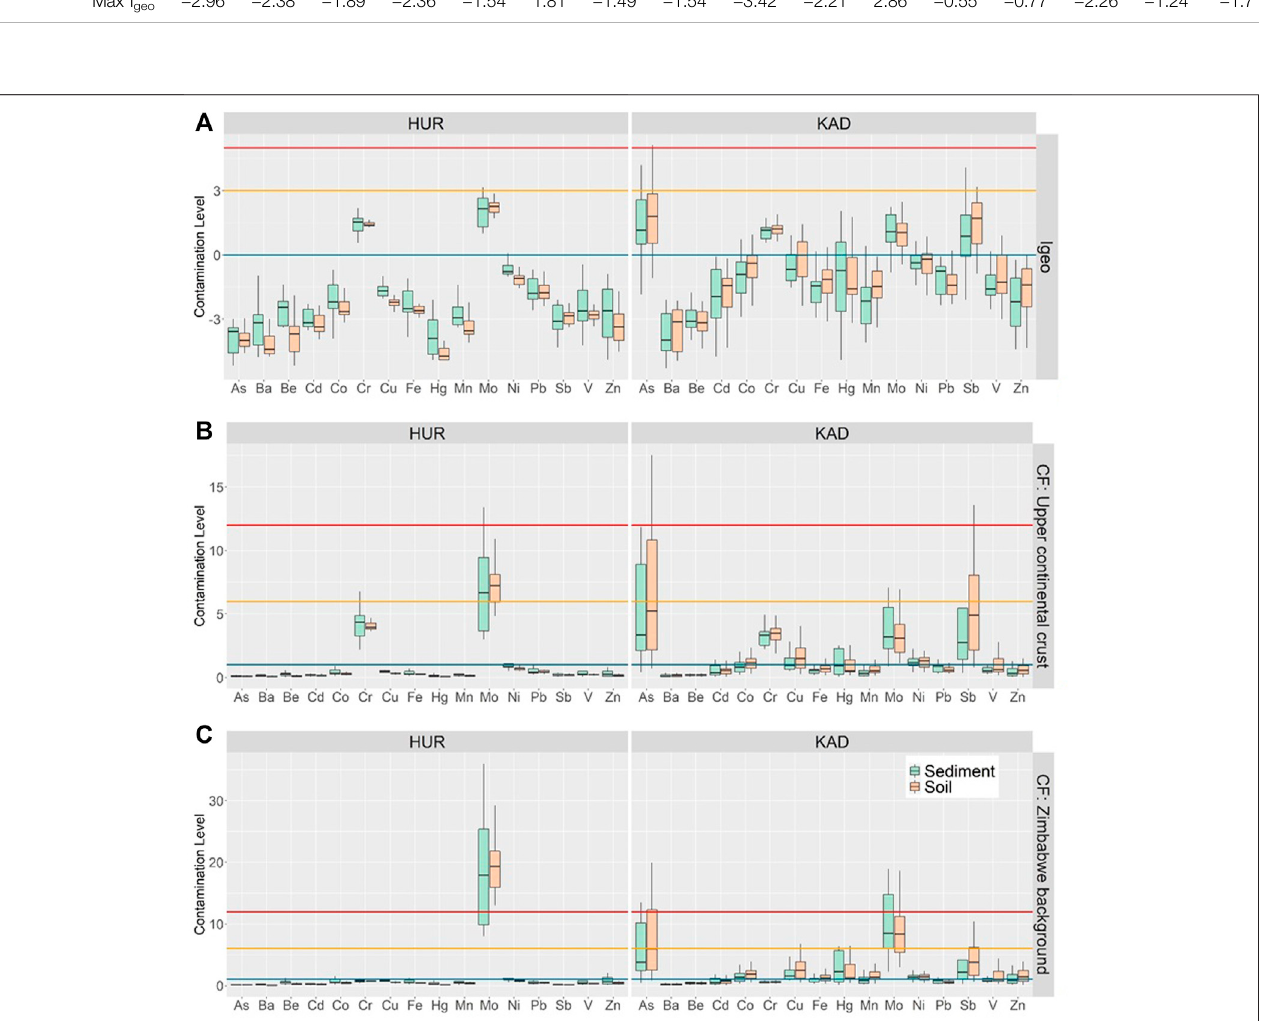
FIGURE4| Boxand whiskerplotsillustratingthesingle pollutionindicesIgeo (A) ,andCFofPHE insoils (B) andstreamsediments (C) .Outlierswerenotplottedto aid visualisation.